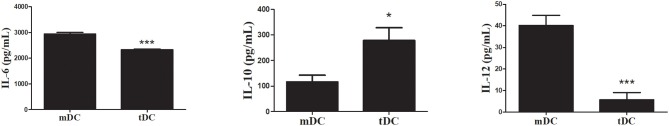
TDCs exhibit an anti-inflammatory cytokine secretion profile. Concentrations of IL-6 (A), IL-10 (B), and IL-12p70 (C) were determined in mDCs or tDCs supernatants by ELISA. Values represent the mean of nine determinations ± SEM of three experiments performed. ***P < 0.001; compared to mDC cells. *P < 0.05; compared to mDC cells.